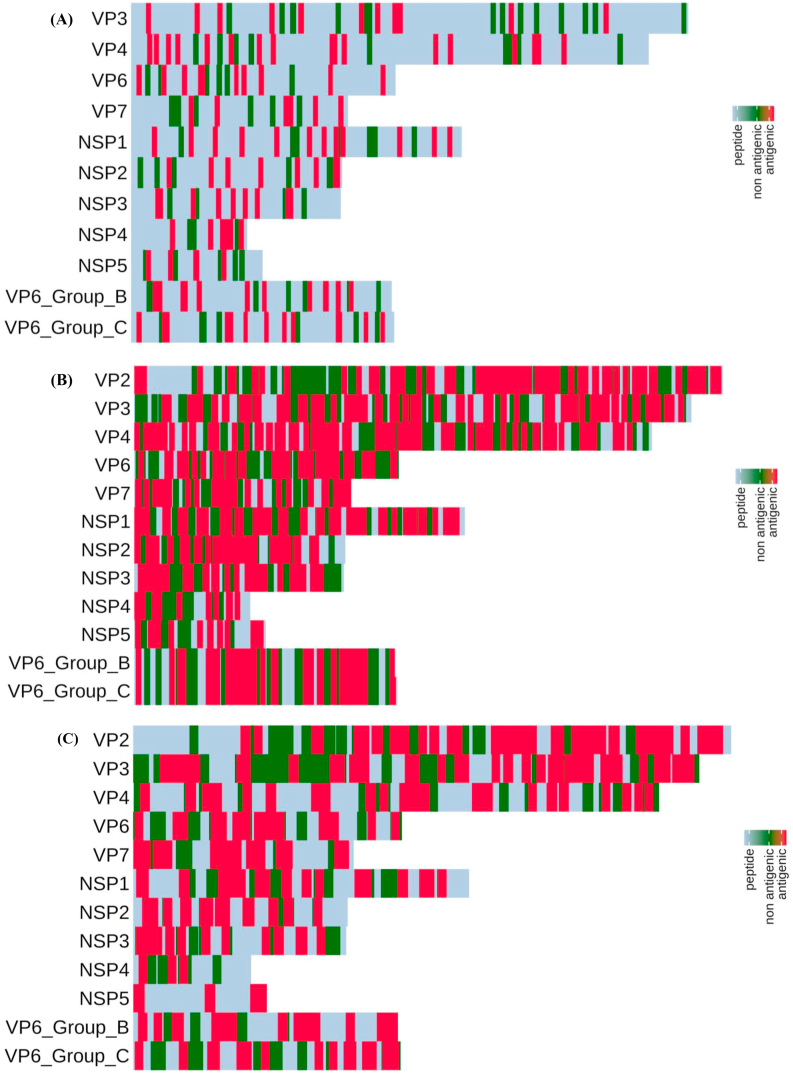
Summary of rotavirus protein-derived B- and T-cell epitopes. Heat map showing the distribution of (A) linear (continuous) B-cell epitopes, (B) HLA-class I and (C) II epitopes across the structural and non-structural protein sequences of rotavirus. Strong binding affinity epitopes with <0.5% rank and 2% rank, to HLA class I and class II, respectively, for each HLA molecule are represented here. Red color represents likely antigenic epitopes that were predicted using the methods described in Figure 1.